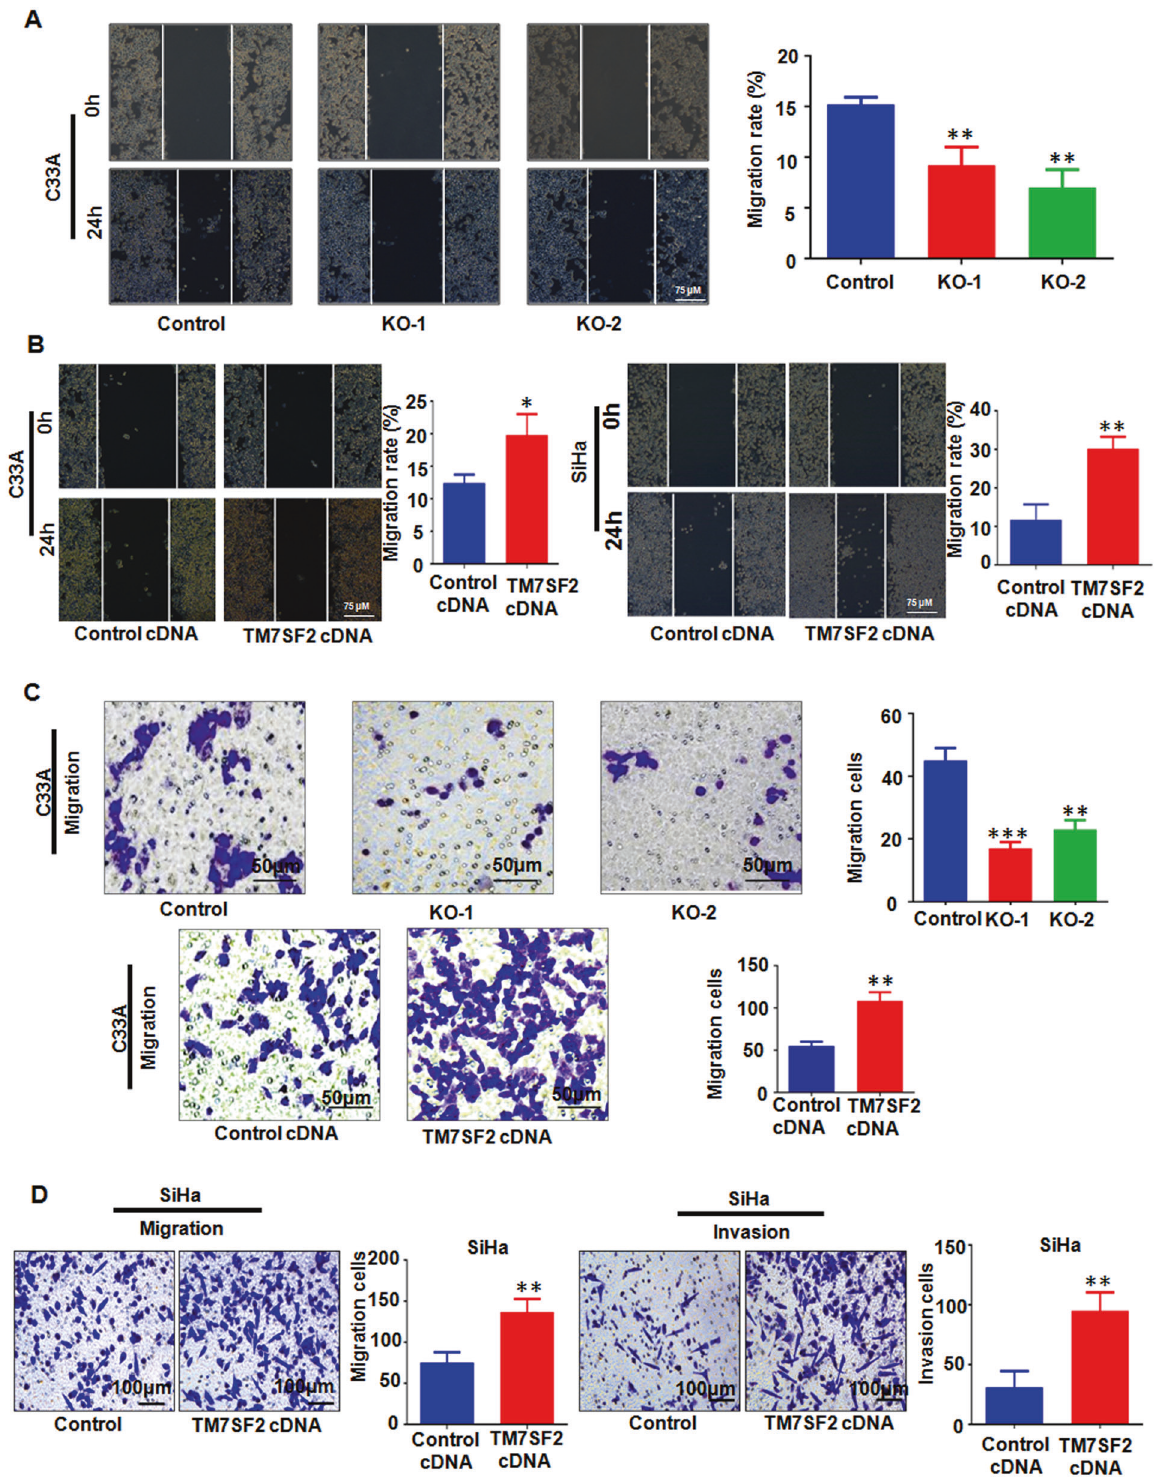
Fig. 3 TM7SF2 promotes migration and invasion of cervical cancer cells. A Left panel: the effect of TM7SF knockout on wound healing in C33A cells. Right panel: quantitative analysis for left panel. ** p < 0.01 compared to control. B Left panel: the effect of TM7SF overexpression on wound healing in C33A and SiHa cells. Right panel: quantitative analysis for left panel. * p < 0.05, ** p < 0.01 compared to control. C Left panel: the effect of TM7SF knockout or overexpression on migration by Transwell assay in C33A. Right panel: quantitative analysis for left panel. ** p < 0.01, *** p < 0.001 compared to control. D Left panel: the effect of TM7SF overexpression on migration and invasion by Transwell assay in SiHa cells. Right panel: quantitative analysis for left panel. ** p < 0.01 compared to control.